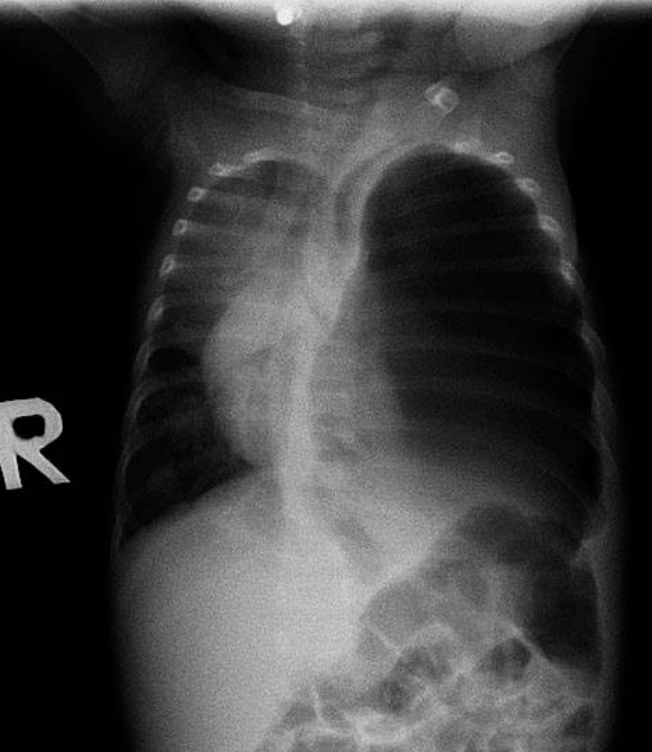
Figure 3. Chest radiograph of 3-month-old infant with shortness of breath reveals presumed tuberculosis-related pneumothorax and resultant mediastinal shift. (All patient images taken with permission of patient or accompanying